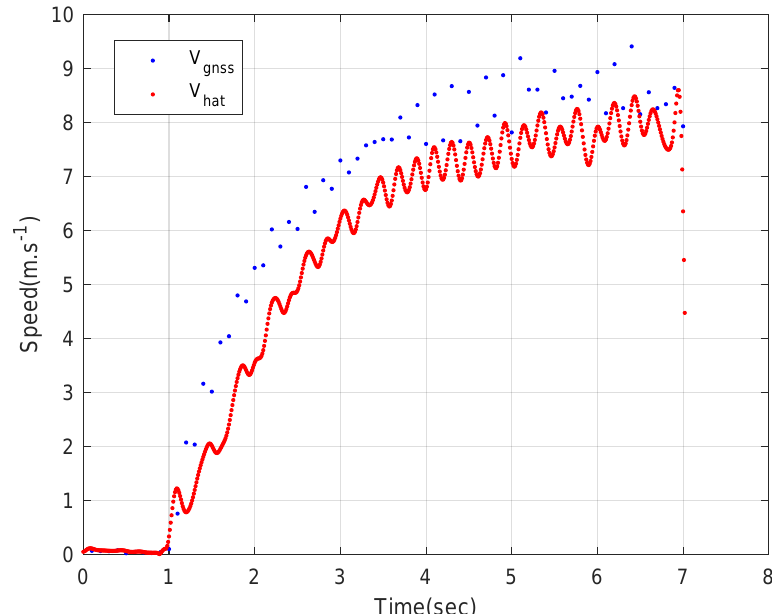
Figure 17. The 2D speed of the